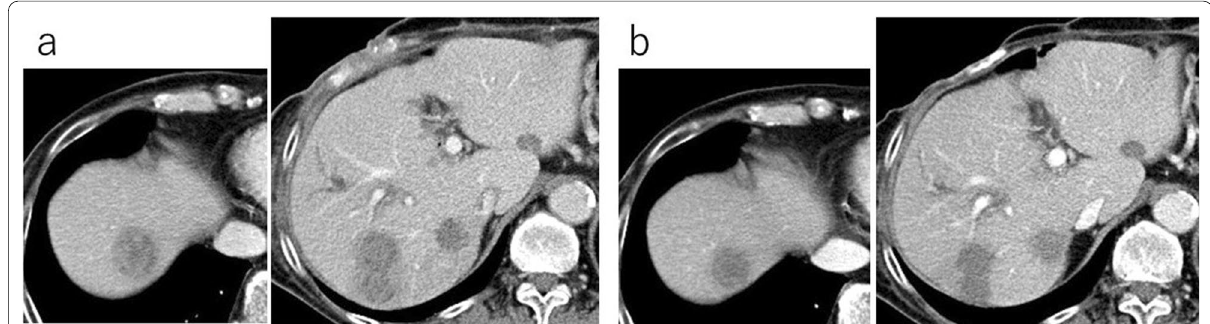
Fig. 5 Contrast-enhanced CT showing the therapeutic effect of PR after six courses of GC. a Before chemotherapy. b After six courses of